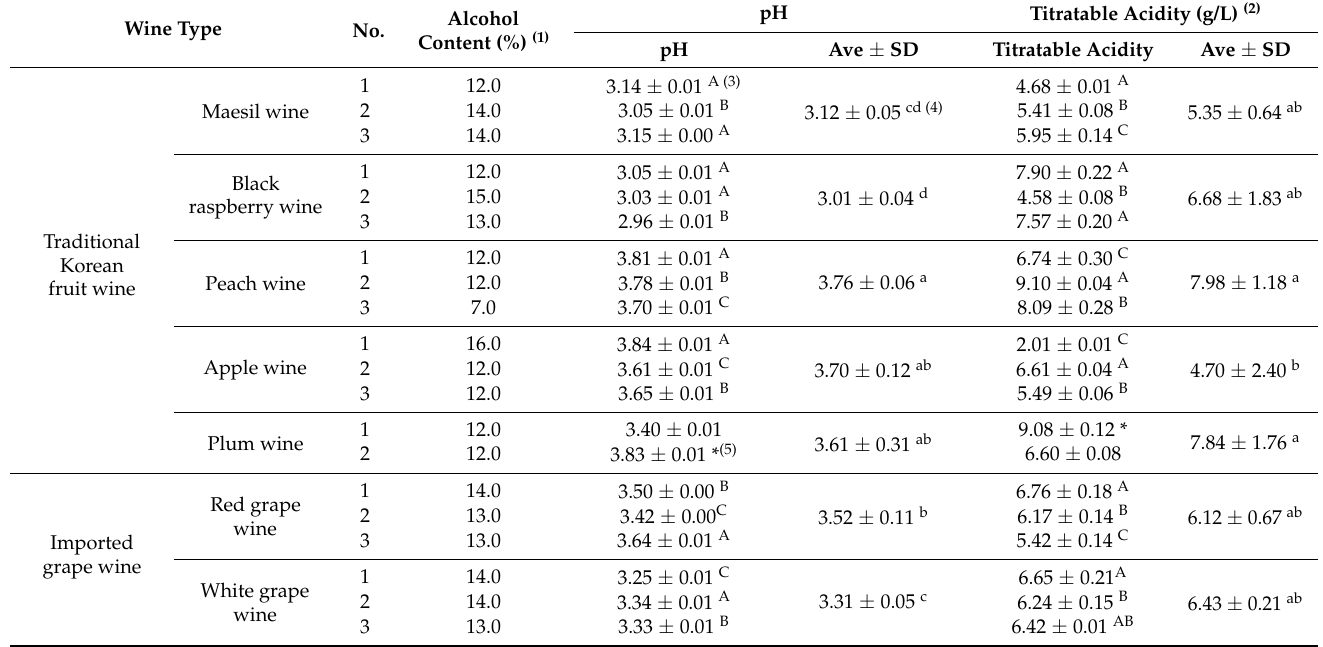
Table 1. Alcohol content, pH level, and titratable acidity content in fruit